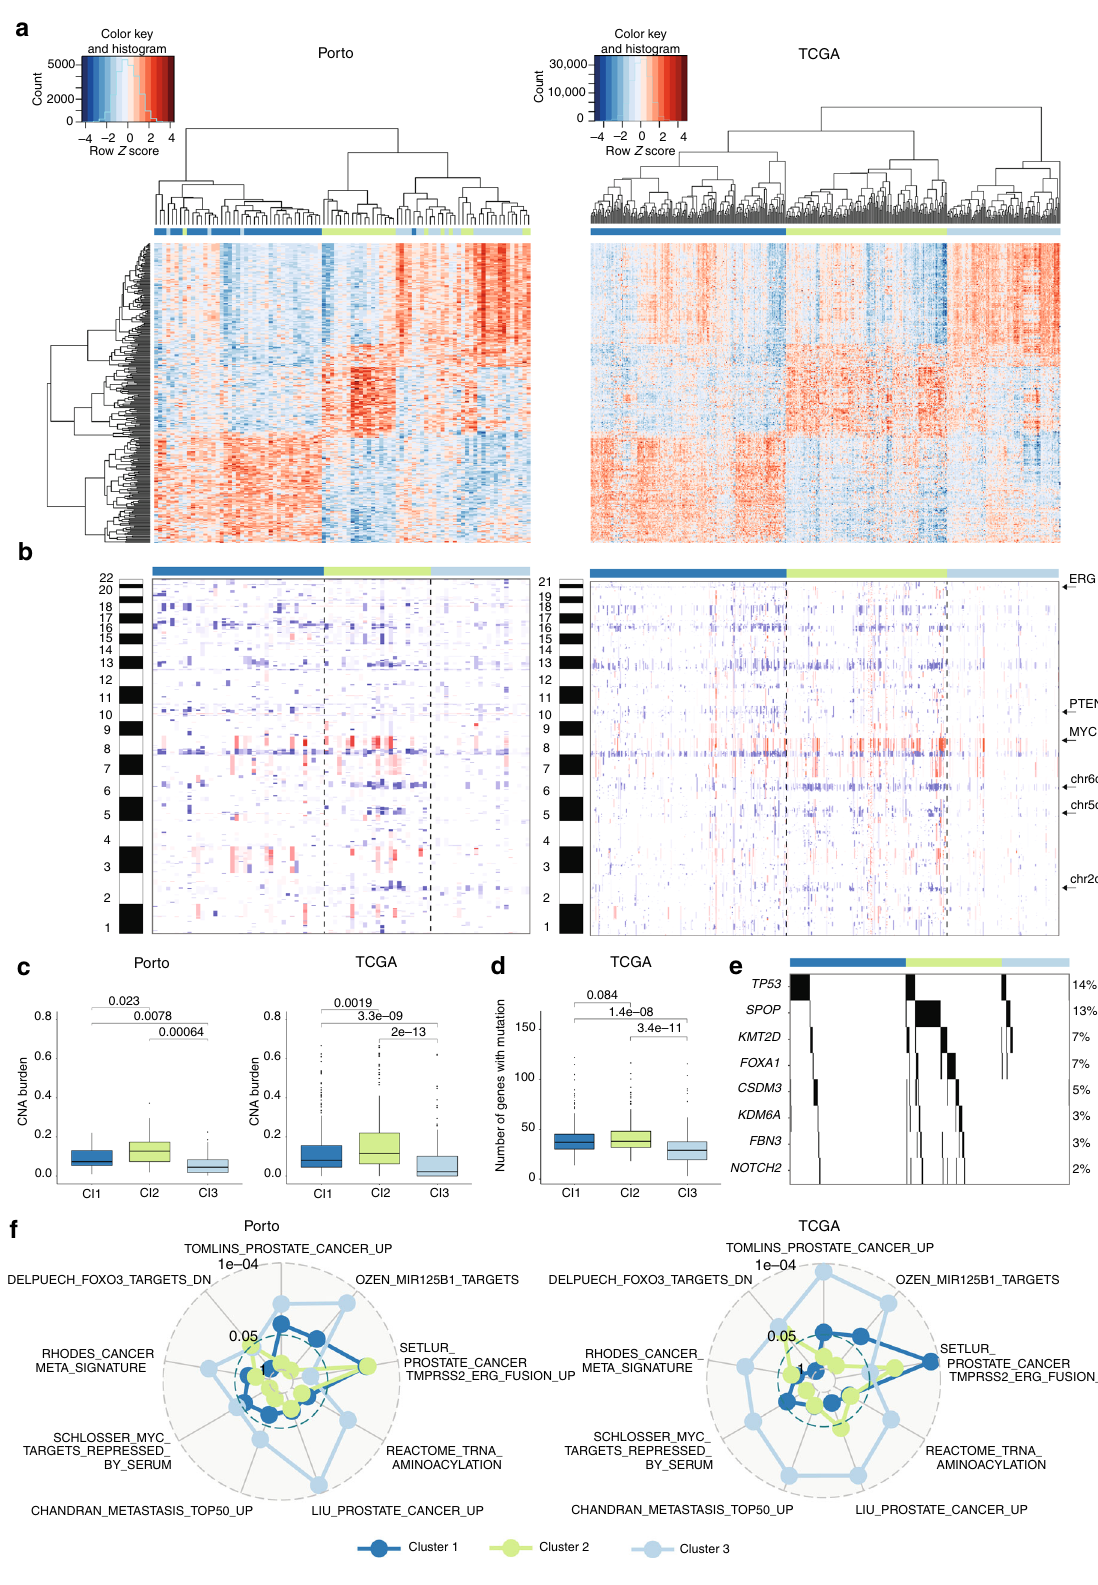
dataset, the TCGA dataset is partitioned into three clusters with comparable expression pro fi les as the three clusters in the Porto cohort (Fig. 5a). The three identi fi ed clusters in both the Porto as well as the TCGA cohort will be termed hereafter as cluster 1 (Cl1), cluster 2 (Cl2), and cluster 3 (Cl3).